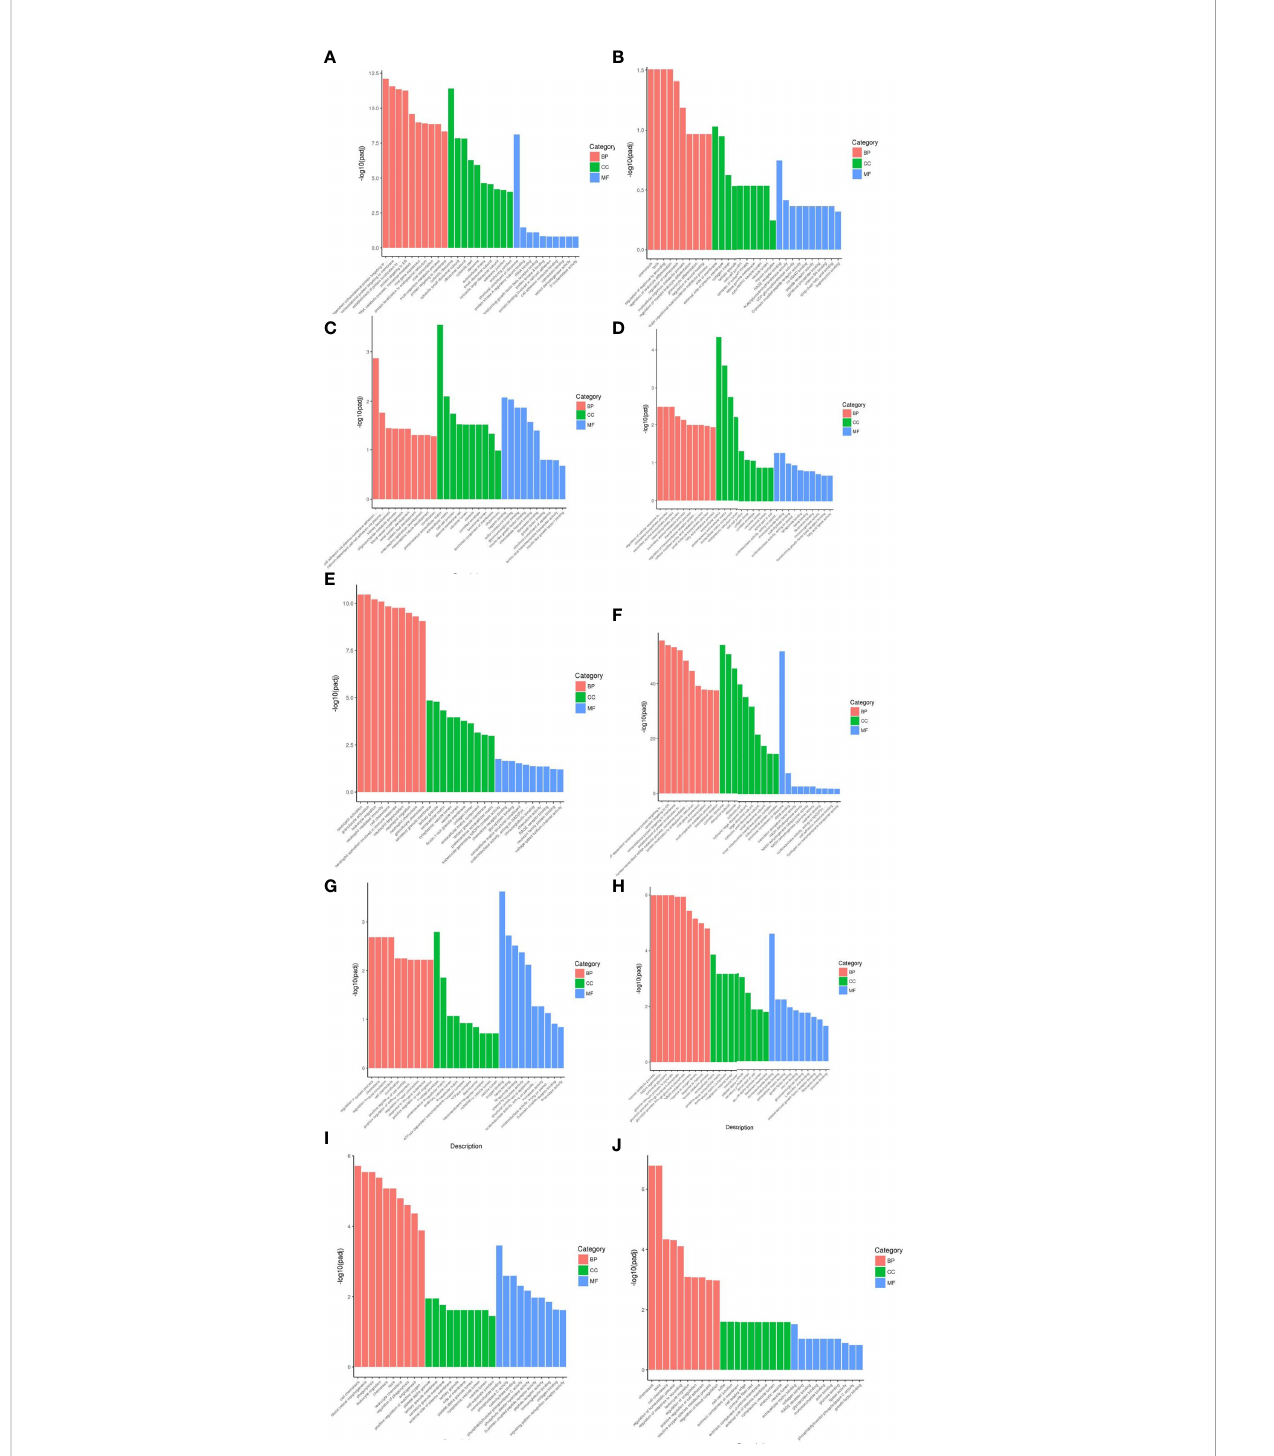
FIGURE 4 ResultsofGOfunctionalenrichmentanalysisofdifferentiallyexpressedgenes.FromtheresultsofGOenrichmentanalysis,themostsigni fi cant30Term wereselectedtodrawbarchartsfordisplay,andiflessthan30,allTermwereplotted,withbarchartsdrawnbythethreemajorcategoriesofbiological process,cellularcomponentandmolecularfunctionandup-anddown-regulationofdifferentialgenes.BPdenotesbiologicalprocess,CCdenotes cellularcomponent,MFdenotesmolecularfunction. (A) Weightloss1-5kgvsControl, (B) Weightloss1-5kgvsWeightloss0kg, (C) Weightloss5-10kgvs Weightloss1-5kg, (D) Weightloss5-10kgvsControl, (E) Weightloss5-10kgvsWeightloss0kg, (F) Weightloss>10kgvsWeightloss1-5kg, (G) Weightloss >10kgvsWeightloss5-10kg, (H) Weightloss>10kgvsControl, (I) Weightloss>10kgvsWeightloss0kg, (J)